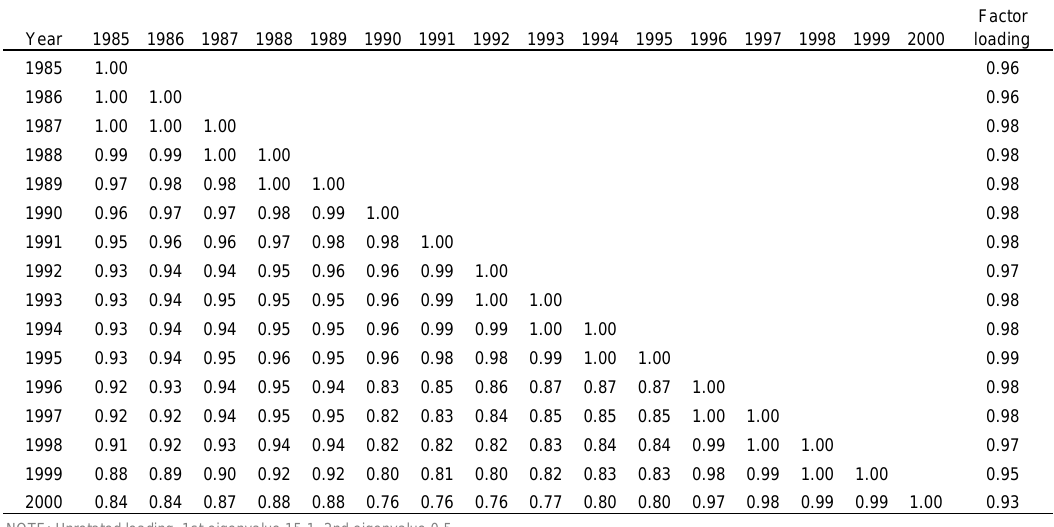
Figure A1. Government social spending as a % of GDP, 1985–2000. Correlations and unrotated factor loadings for 34 societies.